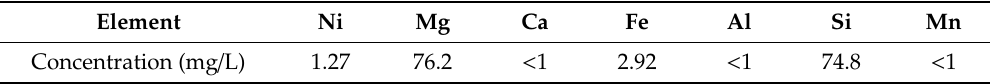
Table 4. Chemical composition of solution after carbonation.